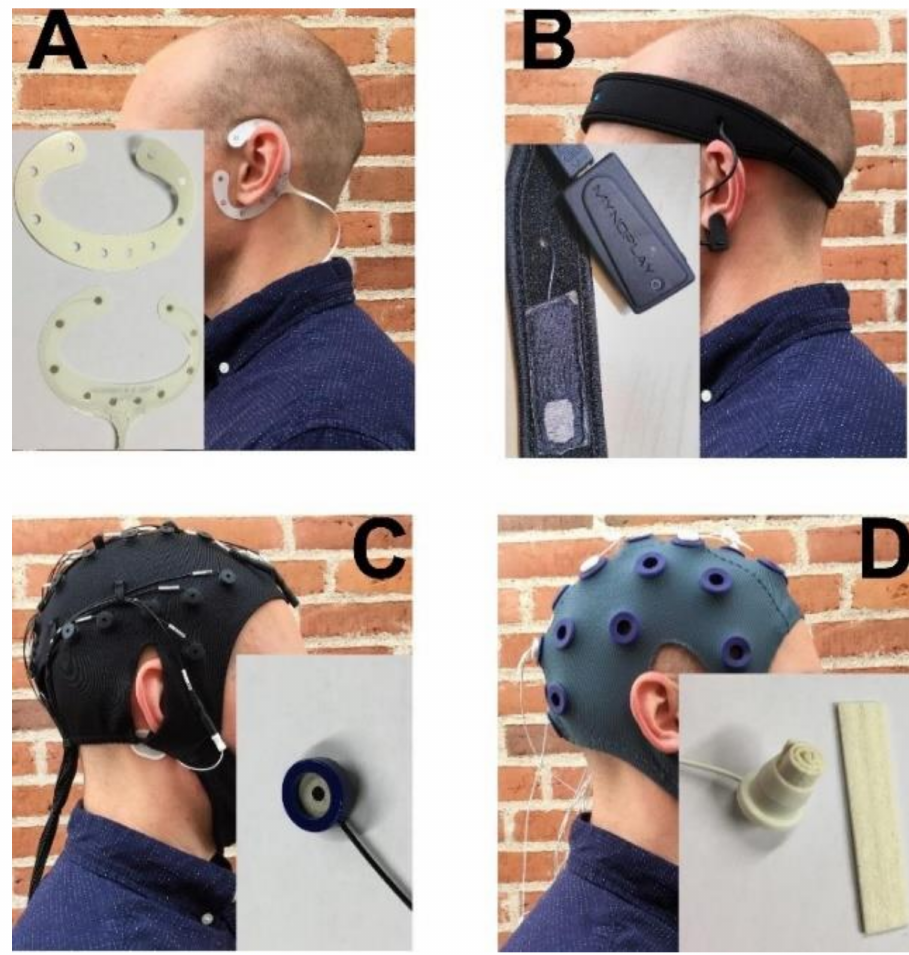
Figure 1. Overview of the four headsets and the electrode types. ( A ): cEEGrid from TMSi. The inset shows the sensor array and the double-sided adhesive tape. The channel in the upper part of the “C” when mounted is channel 1, and the channel numbers ascend clockwise on the electrode. ( B ): MyndBand from MyndPlay. The inset shows the dry electrode and the Bluetooth unit that transmits the data. ( C ): Quick-Cap from Compumedics. The inset shows the electrode type that is mounted in the cap. ( D ): Water-based headset from TMSi. The inset shows the electrode house and the felt